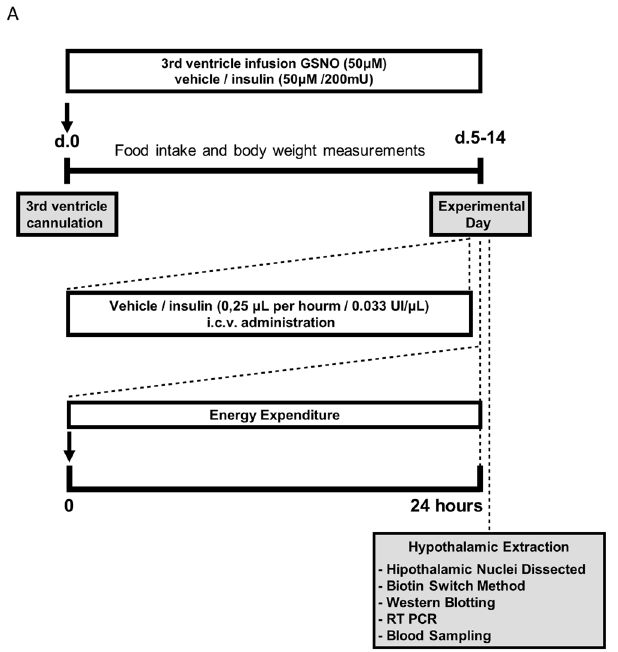
Figure 5. Experimental